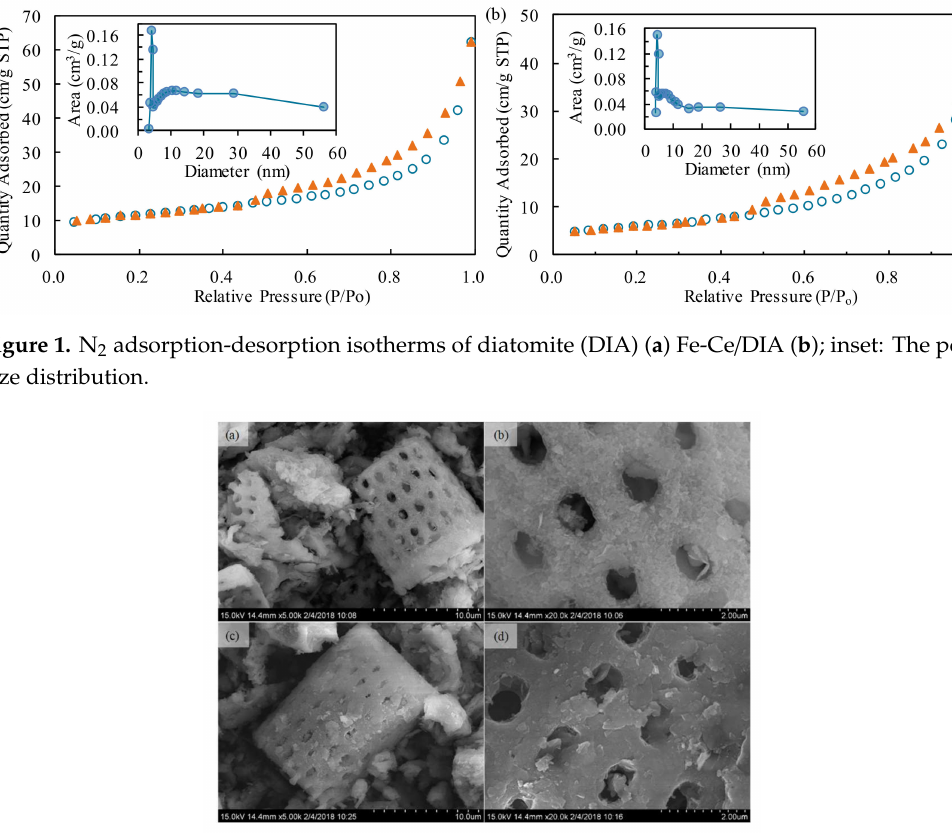
Figure 2. SEM images of DIA ( a , b ) and Fe-Ce / DIA ( c , d ).